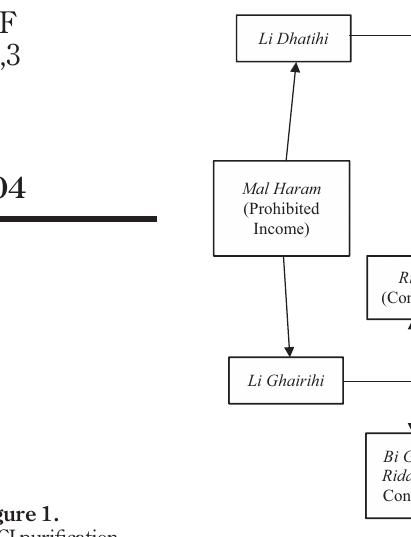
Figure 1. SNCI puri fi cation